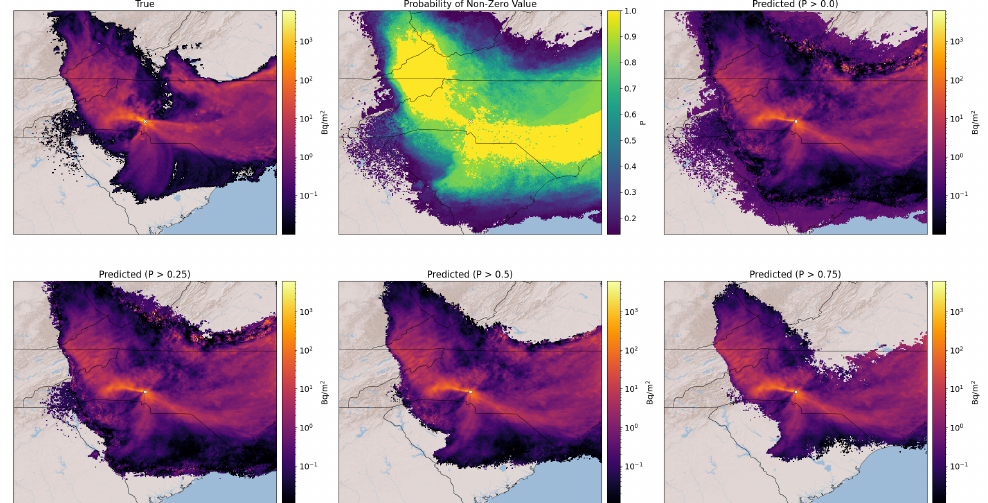
Figure 5. True FLEXPART-WRF output vs. predicted output at several decision threshold values for the surface release ensemble member 0 with n = 50. The WRF parameterization choices for this ensemble member were PBL 1, LSM 1, CU 1, MP 2, and RA 1. The top middle plot shows the original decision threshold